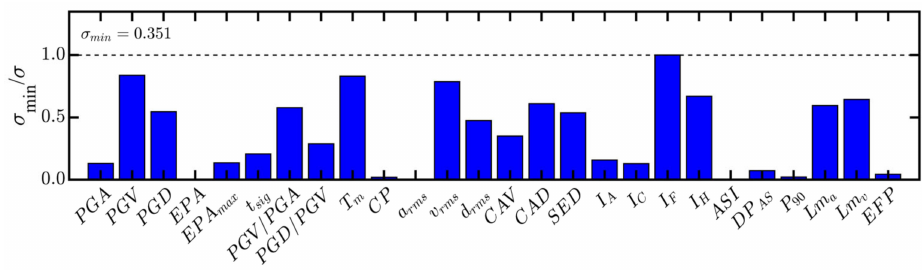
Figure 5. Performance evaluation of conventional IMs in predicting the rocking overturn.